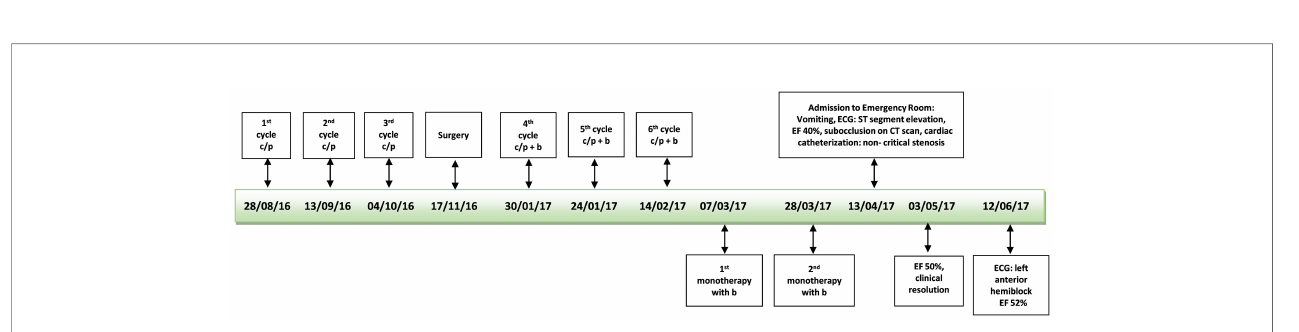
FIGURE 1 | Sagittal CT scan of the abdomen: the arrows show a dilated stomach and ileal